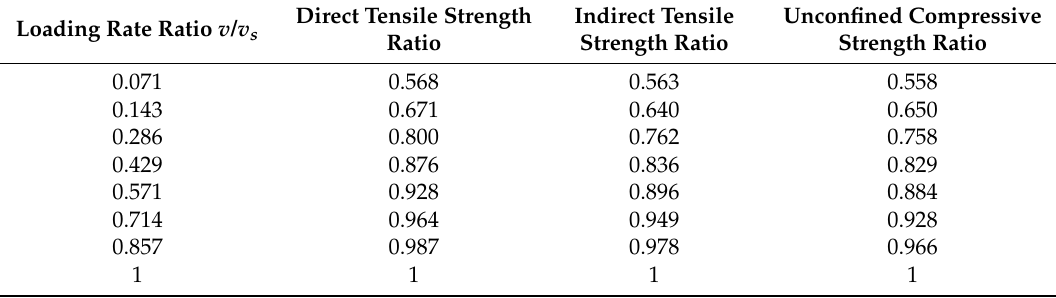
Table 11. Relation between strength ratio and loading rate ratio.